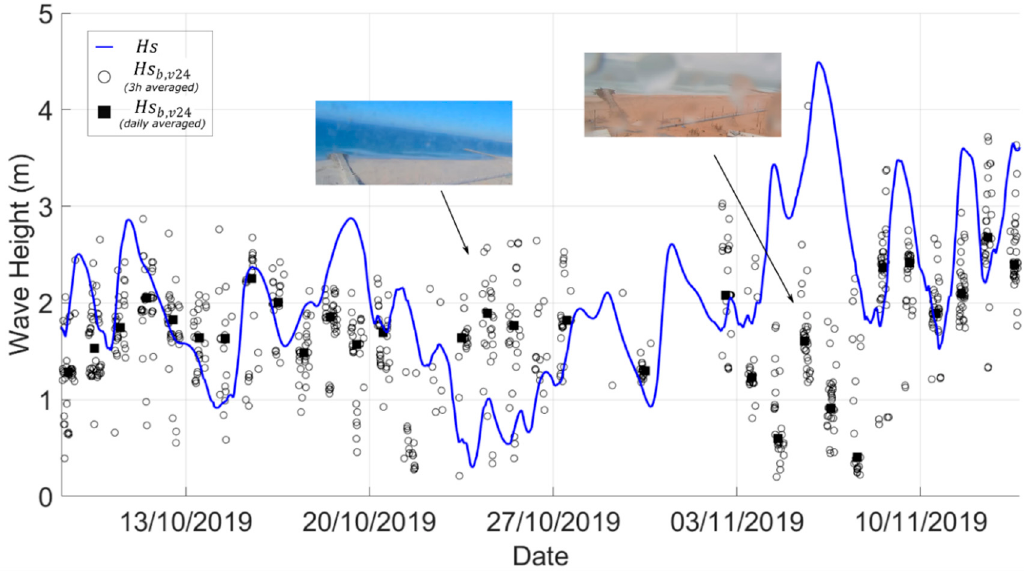
Figure 9. Video-derived breaking wave height Hs b , v 24 [58]. Insets show two examples of images with dirty lens, rain drops and presence of rip currents in the nearshore, which led to poor results.